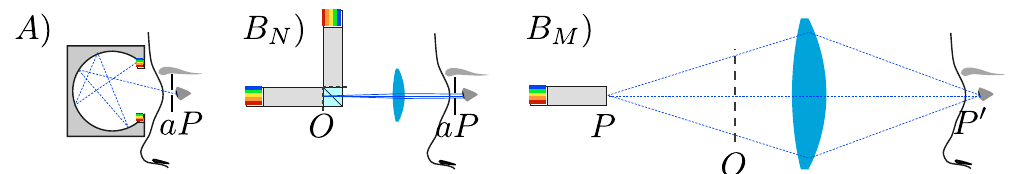
Figure 3. ( A ) Light sources around the exit hole of a small Ganzfeld are mixed and scattered back to an eventual artificial pupil ( aP ) before the eye. ( B N ) Le light is mixed within a pipe with a field stop at its end ( O ) and combined with another similar light source. The field stop is then observed through an ocular. ( B M ) A mixed light source output ( P ) is imaged into the eye pupil ( P (cid:48) ) and the front lens has a very large numerical aperture to allow a large field of view, and the eyes observe an image of O